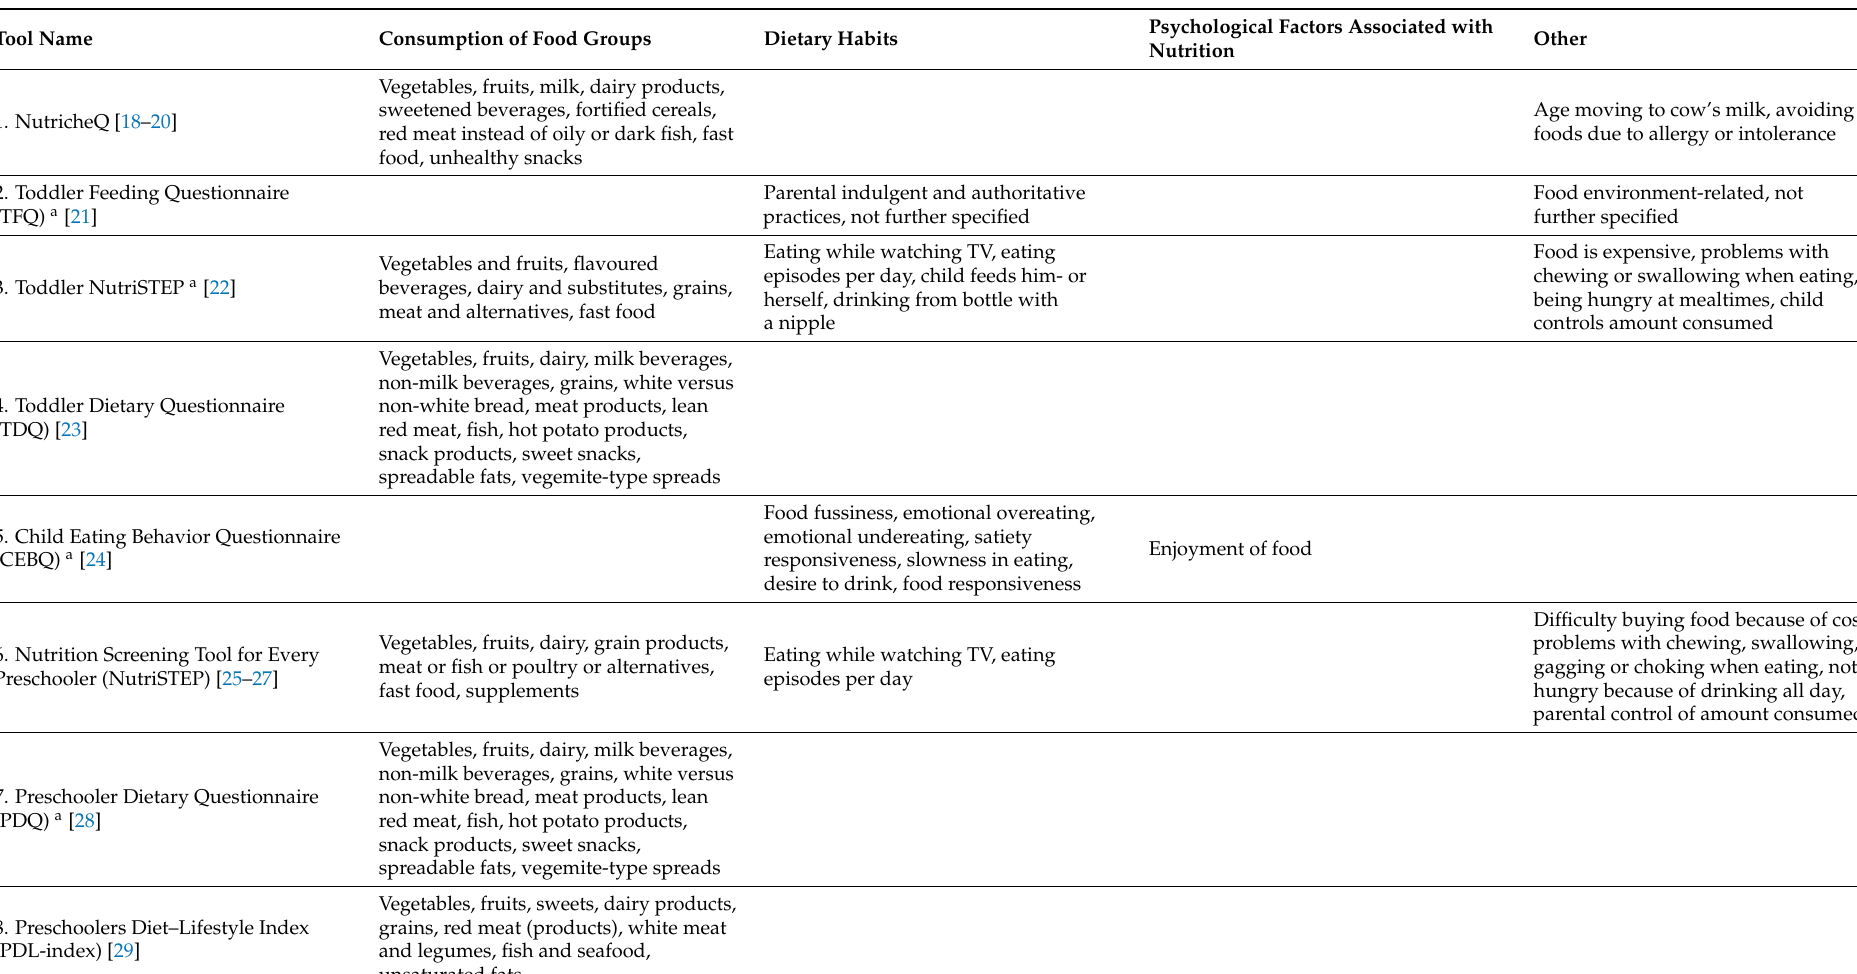
Table 3. Addressed nutrition items of lifestyle screening tools for children in the community